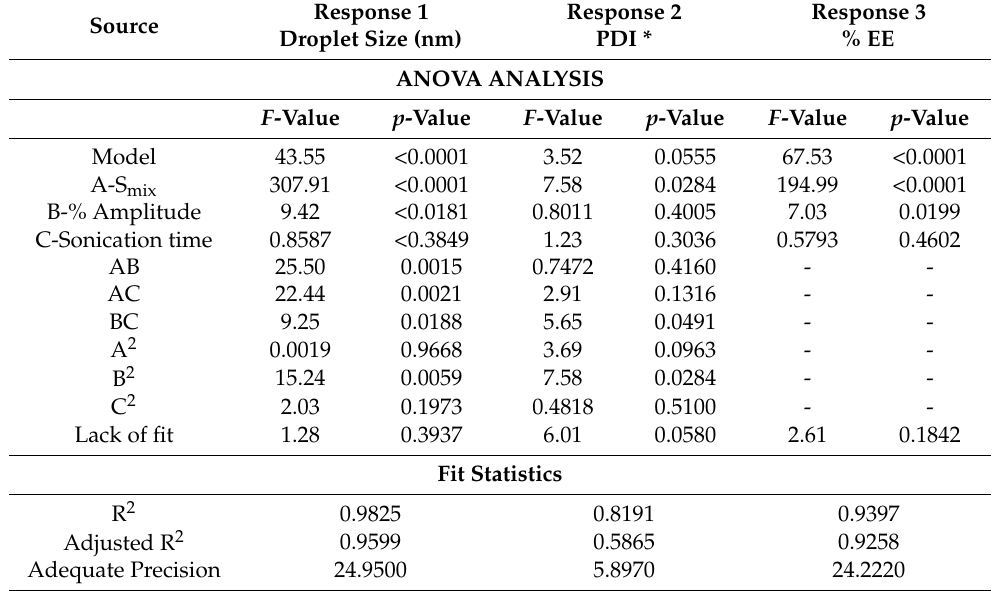
Table 2. Optimization of Que-NE by Box–Behnken design.